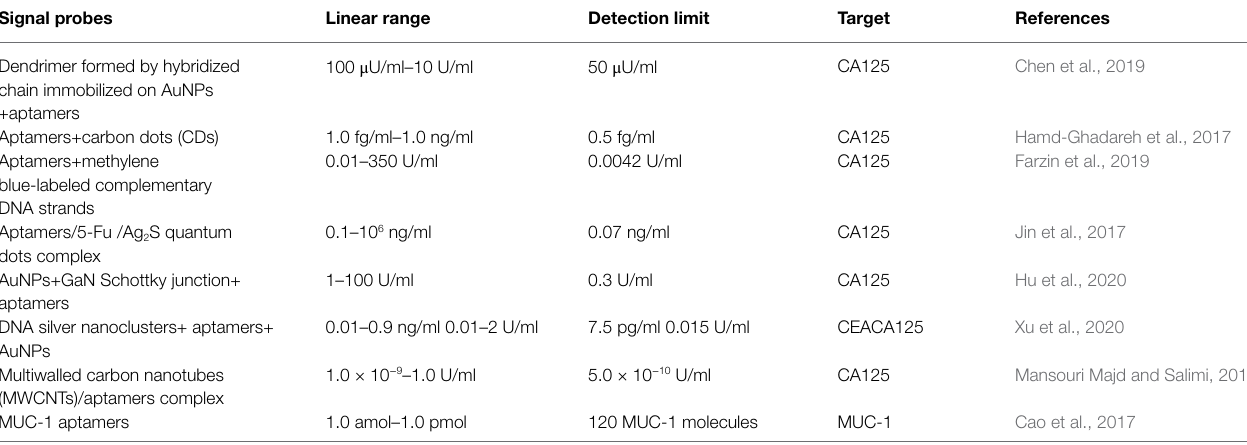
TABLE 2 | Characteristics of signal probes-based